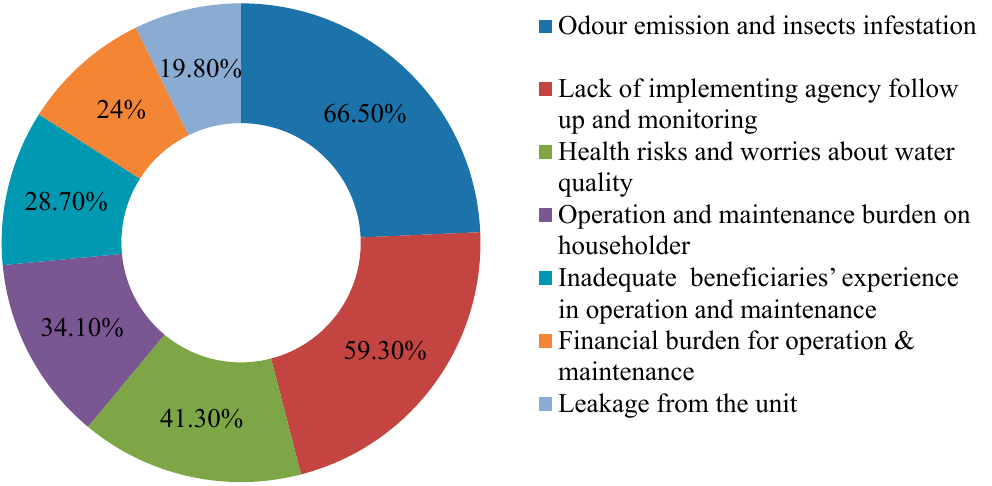
Figure 8. Barriers of providing onsite GWTPs.